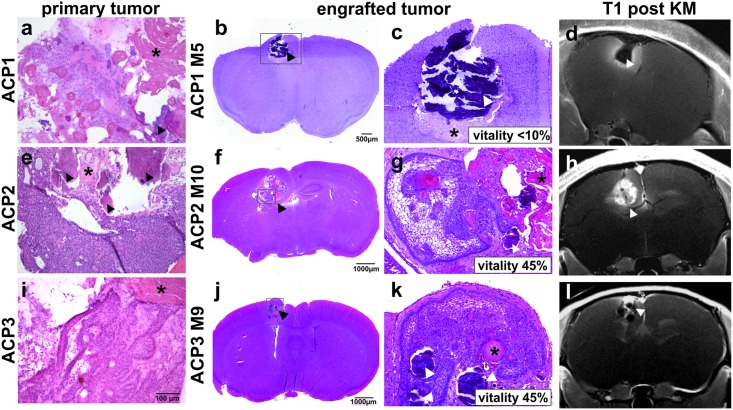
Comparison of patient specific engrafted tumors.Primary (a, e and i) and descended transplanted ACP tissue (b, c, f, g, j and k) show comparable histological appearance with regressive changes e.g. wet keratin (*) and calcifications (arrowhead) with estimated vitality indicated in the magnified images. Associated T1 weighted MR images after contrast medium application (d, h and l) are shown for comparison with histological appearance.